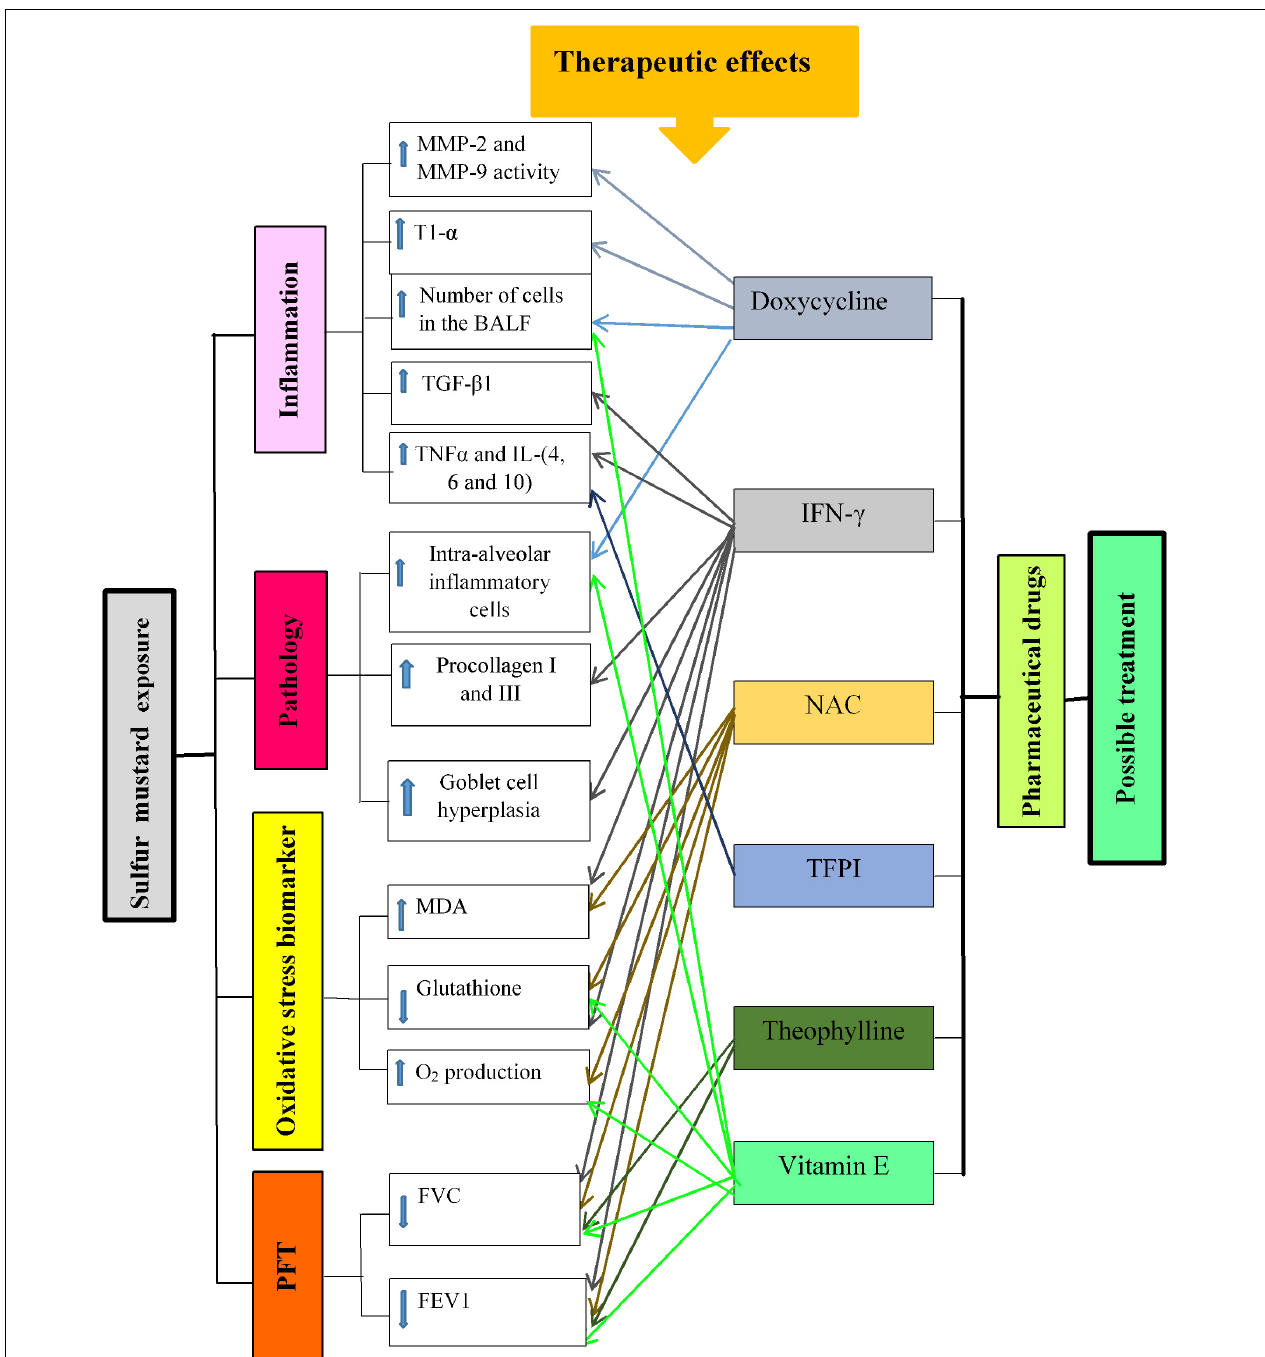
FIGURE 2 | Possible mechanisms of lung injury induced by SM exposure and the effect of pharmaceutical drugs in these changes. T1- α , type I alveolar epithelium protein; MMPs, matrix metalloproteinase; BALF, bronchoalveolar lavage fluid; TGF- β 1, transforming growth factor-beta1; IL, interleukin; IFN γ , interferon gamma; TNF α , tumor necrosis factor- α ; NO, nitric oxide; MDA, malondialdehyde; FVC, forced volume capacity; FEV1, volume in one second.